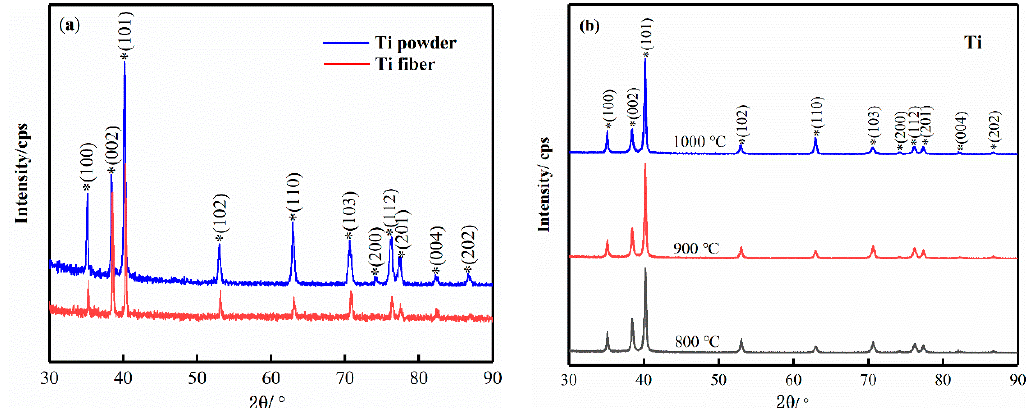
Figure 2. XRD patterns of raw materials and samples: ( a ) is the original Ti powder and Ti fiber; ( b ) is the samples with different sintering temperatures (800 °C, 900 °C and 1000 °C).